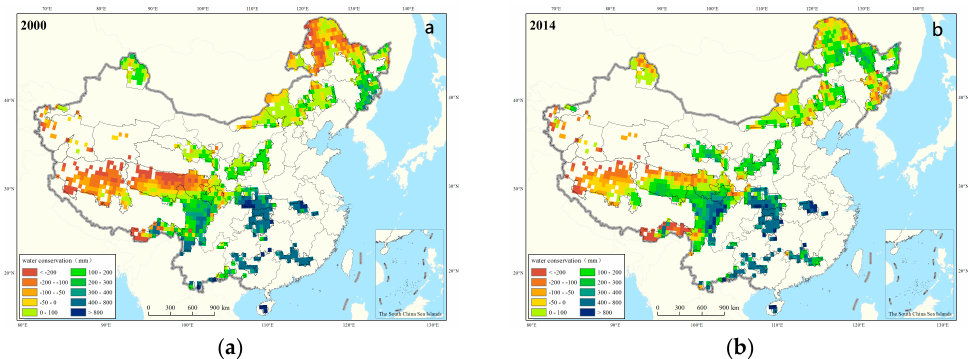
Figure 5. Spatial distribution and change of water conservation in national key ecological function zones. ( a ) The year of 2000; ( b ) the year of 2014 [66].